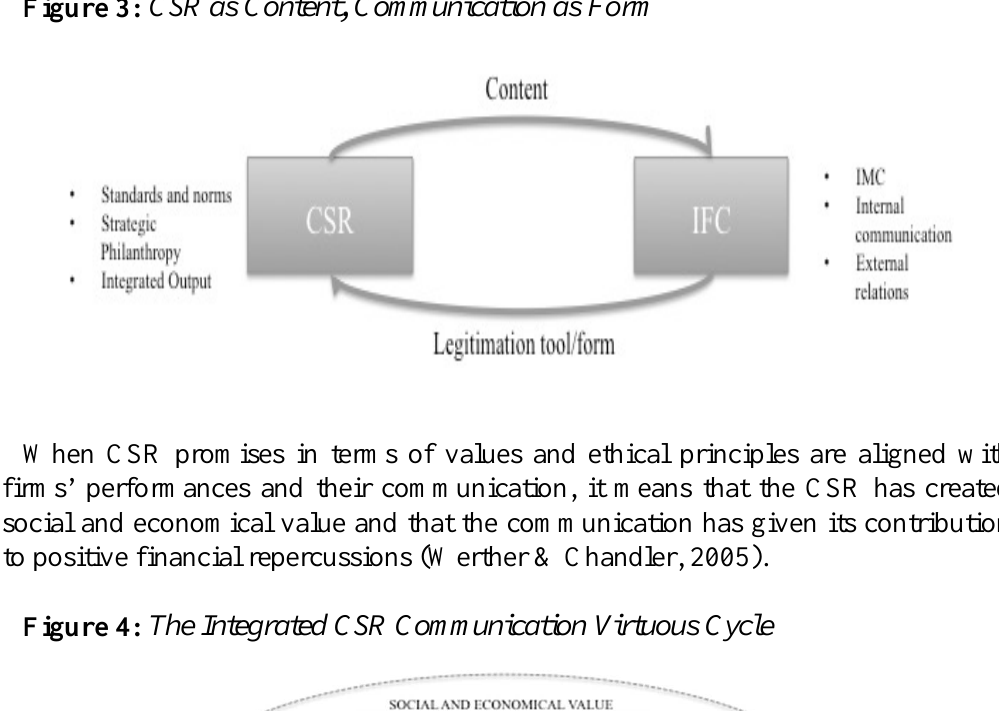
Figure 3: CSR as Content, Communication as Form